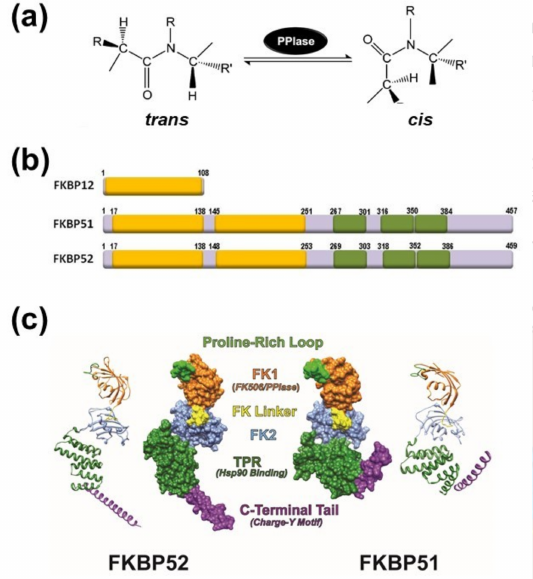
Figure 1. (a) Schematic representation of the peptidyl-prolyl isomerase ( cis/trans ) isomerization activity (PPIase). (b) Schematic structures of FK506-binding protein of 12-kDa (FKBP12) (acc.# AAA58476), FKBP51 (acc.# Q13451) and FKBP52 (acc.# NP_002005). The PPIase domain is depicted as yellow boxes. Only the FK1 domain (the extreme N-terminal of the protein) has PPIase activity. Tetratricopeptide repeats (TPRs) are shown in green color. (c) Ribbon and molecular surface depictions of hFKBP51 crystallo-graphic structure (right) and overlapping fragments encompassing the full length hFKBP52 crystallographic structure (left) are also shown. Note in both proteins that the FK1 domains (orange) containing the PPIase catalytic pocket and the Proline-Rich Loop (green) are connected to the FK2 domain (blue) by the FK Linker (yellow). Both proteins show TPR domains (purple) where Hsp90 binds. Structures were derived from the RCSB PDB (FKBP51: 1KT0; FKBP52: 1Q1C & 1P5Q) with Viewer-Lite 5.0 (Sharpened Productions Inc, Sioux City, IA,